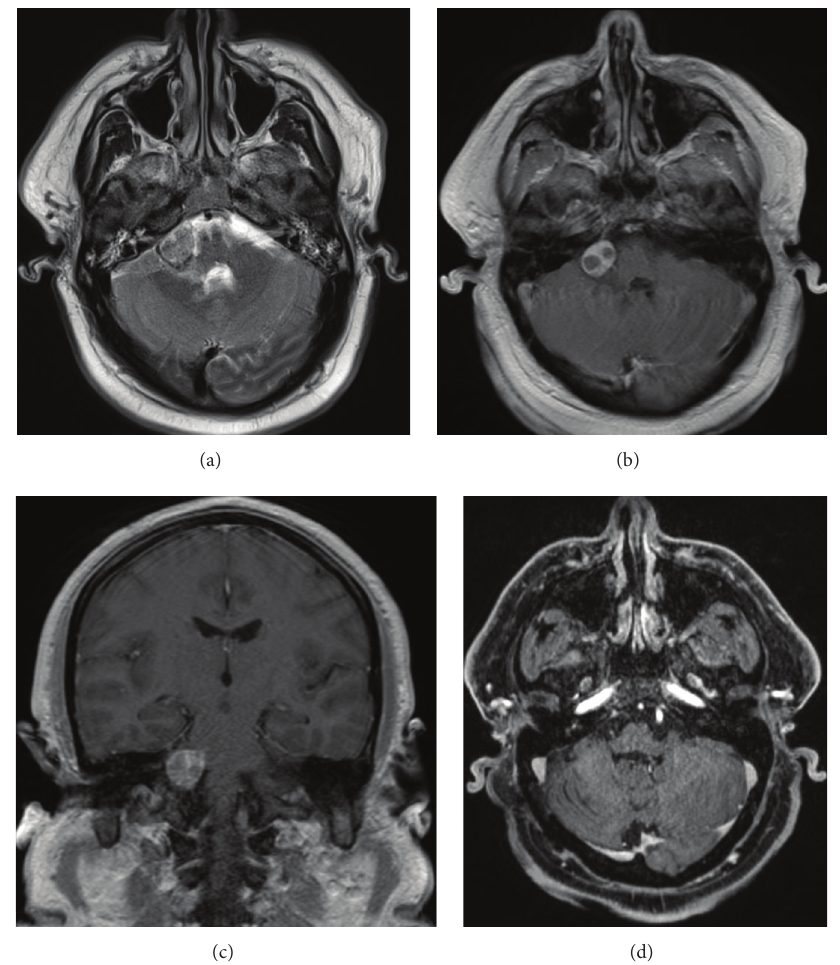
Figure 3: Axial T2-weighted (a) as well as axial (b) and coronal (c) T1-weighted contrast-enhanced magnetic resonance imaging (MRI) of the brain demonstrates an enhanced right cerebellopontine angle mass underlying the hemorrhage in the right cerebellopontine angle with central areas of nonenhancement. One year after resection, axial 3D T1-weighted contrast-enhanced MRI of the brain (d) demonstrates interval postsurgical changes of right retromastoid craniotomy for resection of the right cerebellopontine angle tumor without evidence of residual